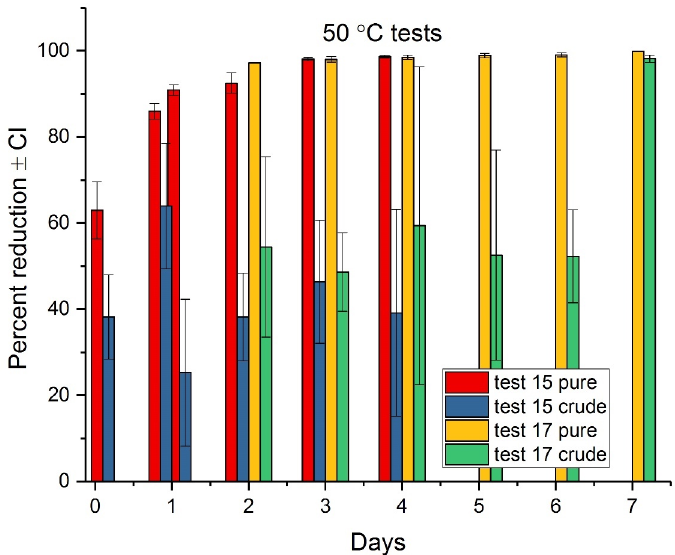
Fig 3. Average attenuation of ricin at 50˚C on mild steel as a function of time. Test 15 evaluated elapsed times from 0.25–4.0 days; Test 17 evaluated 2–7